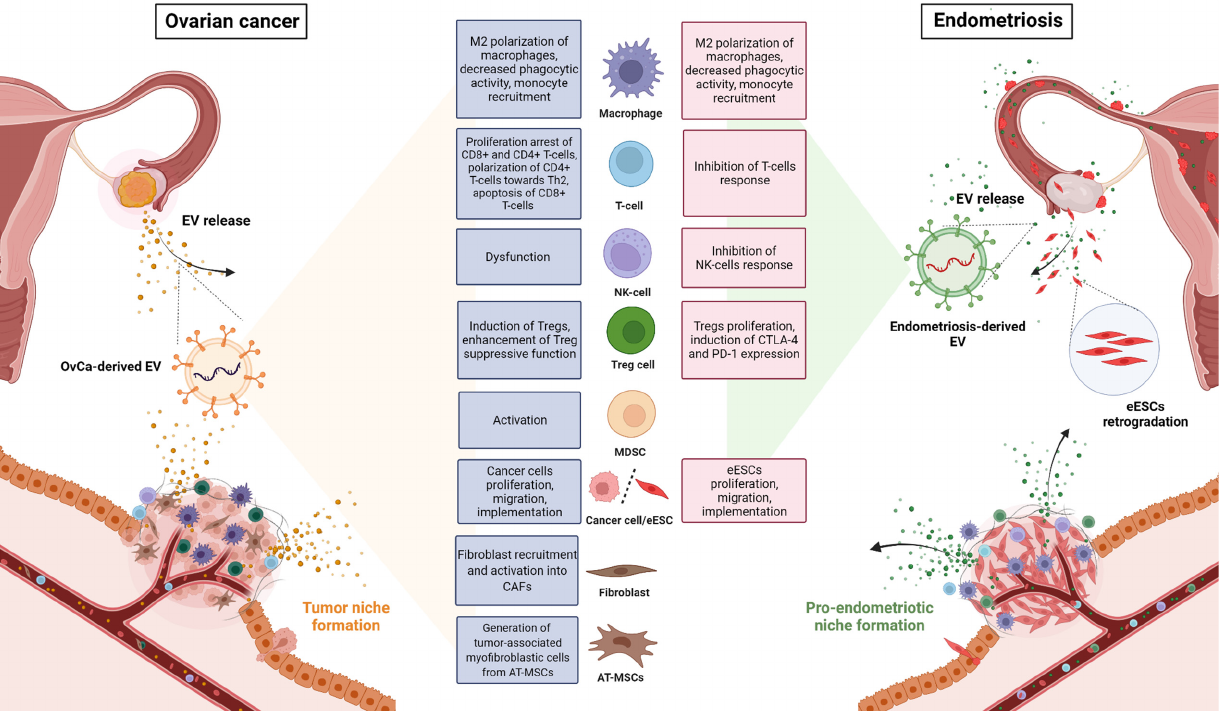
Figure 2. Comparison of extracellular vesicle (EV)-mediated effects on diverse immune and non-immune cell types in tumor and pro-endometriotic microenvironments that promote tumor or endometriotic niche formation. Abbreviations: AT-MSCs, adipose tissue-derived mesenchymal stem cells; CAFs, cancer-associated fibroblasts; CD8+ T-cells; cytotoxic T lymphocytes; CTLA-4, cytotoxic T lymphocyte antigen 4; eESCs, ectopic endometrial stromal cells; M2, pro-inflammatory phenotype; MDSCs, myeloid-derived suppressor cells; MSCs, mesenchymal stem cells; NK-cells, natural killer cells; OvCa, ovarian cancer; PD-1, programmed cell death protein 1; T-cells, T lymphocytes; Th2, T helper cell type 2; Tregs, regulatory T lymphocytes. This image was created using BioRender (http://biorender.com/ accessed on 22 April 2022).